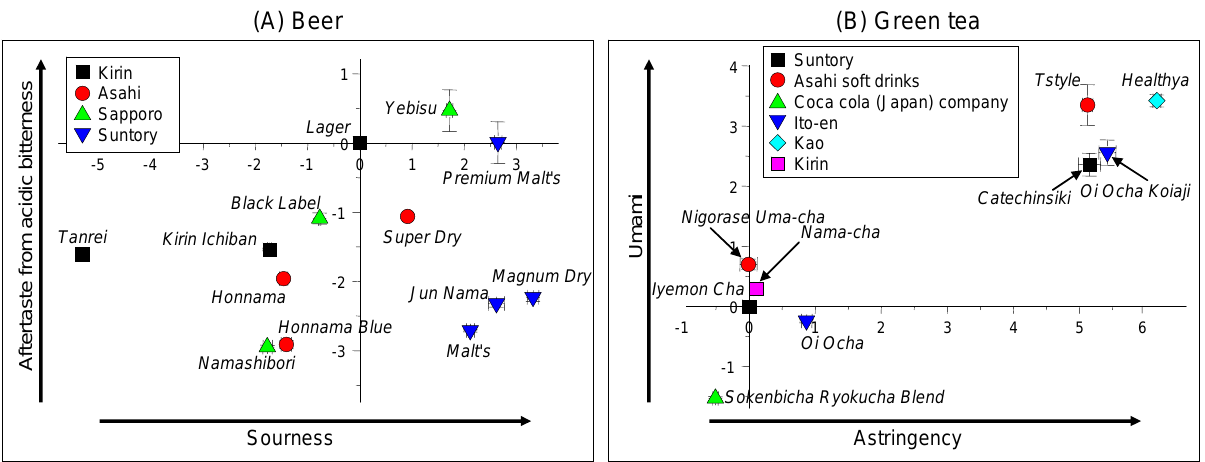
Figure 16. Taste maps for beer and green tea. Data are expressed as mean ±SD deviation (n = 4). In the two figures, Lager and Iyemon Cha were used as controls for beer and green tea, respectively. All taste information for each control sample was set to zero. All beers and green teas are on the Japanese